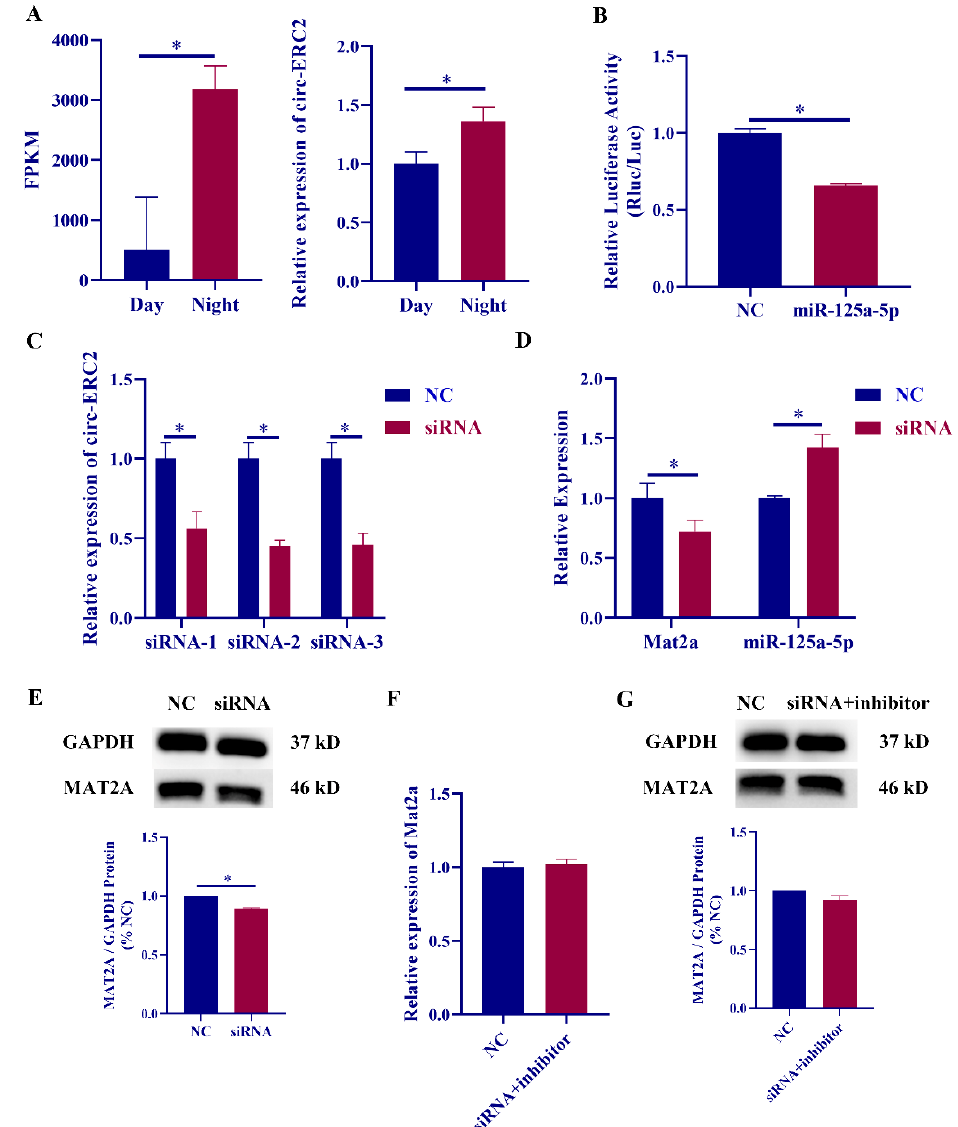
Figure 5. Circ-ERC2 acts as a molecular sponge for miR-125a-5p in pineal cells. ( A ) Relative expression of circ-ERC2 in rat pineal gland during the day and night. ( B ) Dual luciferase reporter assay results for miR-328a-3p, the wild-type circ-ERC2. ( C ) Relative expression of circ-ERC2 in rat pineal cells transfected with circ-ERC2 siRNA. ( D ) Relative expression of mat2a mRNA and miR-125a-5p after circ-ERC2 siRNA-1 transfection. ( E ) Relative expression of MAT2A protein after circ-ERC2 siRNA-1 transfection. ( F ) Relative expression of mat2a mRNA after circ-ERC2 siRNA-1 and miR-125a-5p inhibitor co-transfection. ( G ) Relative expression of MAT2A protein after circ-ERC2 siRNA-1 and miR-125a-5p inhibitor co-transfection. *, p < 0.05.